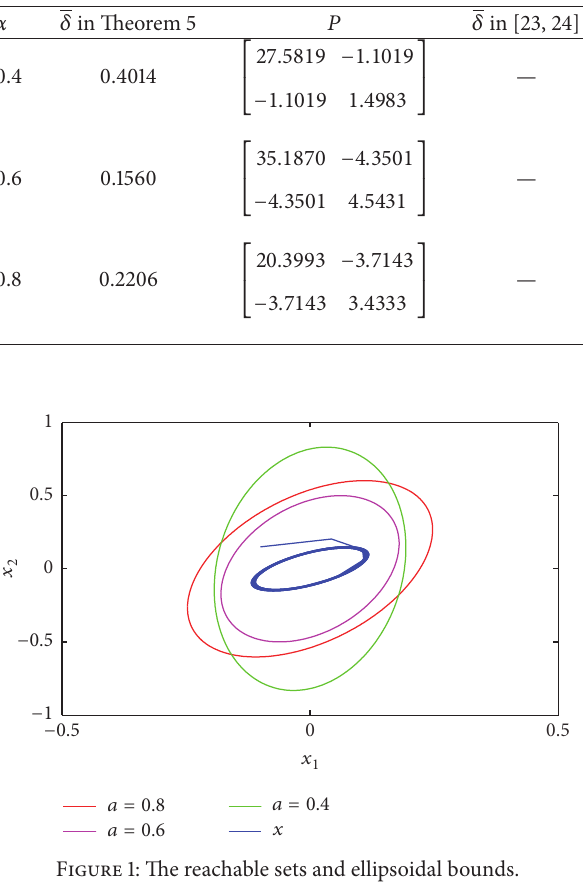
Table 1: Different values of 𝛿 and 𝑃 by choosing different 𝛼 .